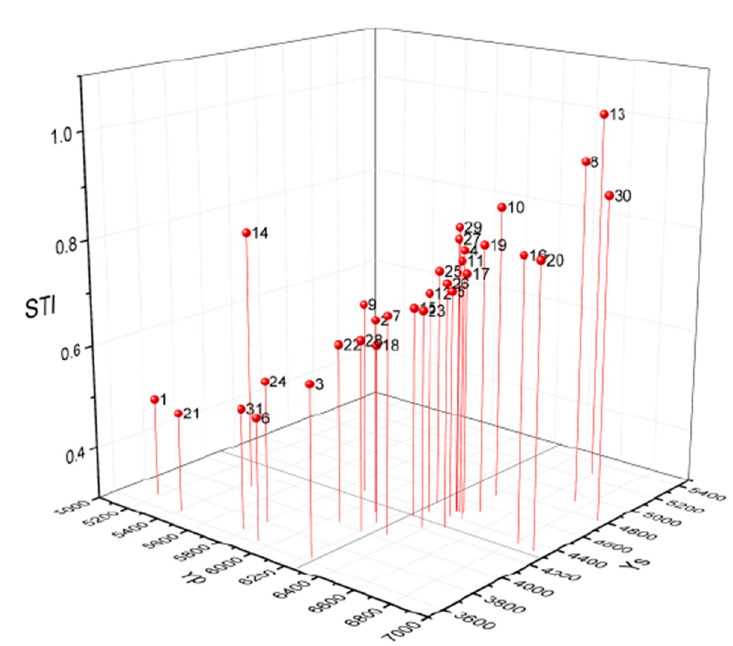
Figure 3. Three-dimensional diagram for identifying LN tolerant genotypes based on Yp and Ys as well as the STI.